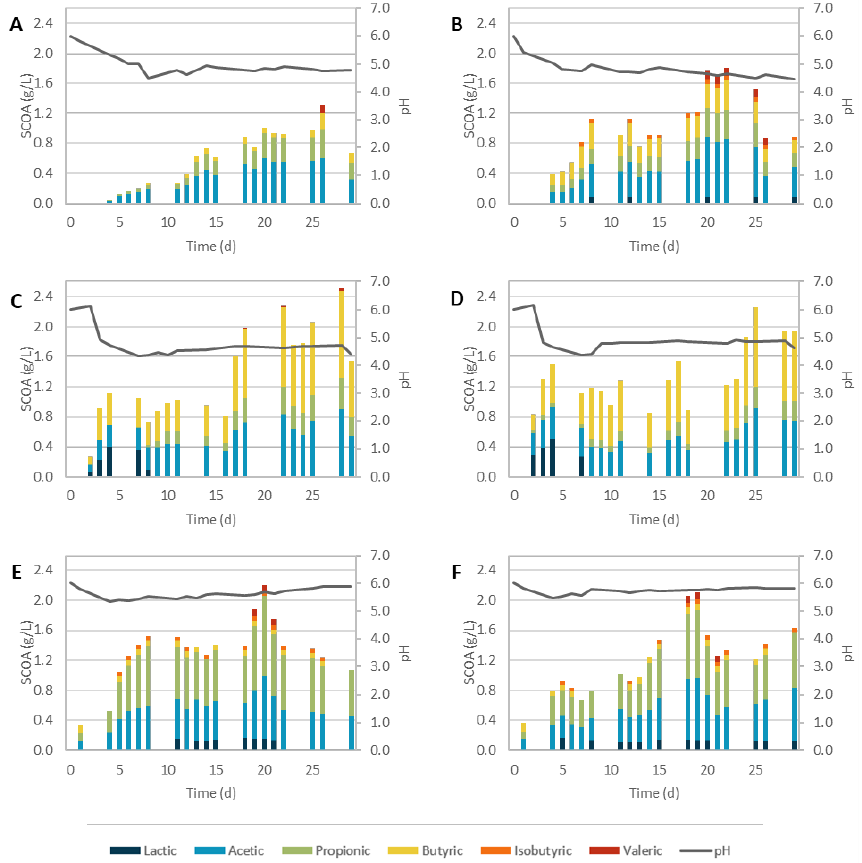
to adapt to. Still, after day 6, a shift in SCOA production was observed, and lactic acid decreased to residual values. The maximum SCOA production was achieved on day 28, and it corresponded to a 93% increase compared to the control.